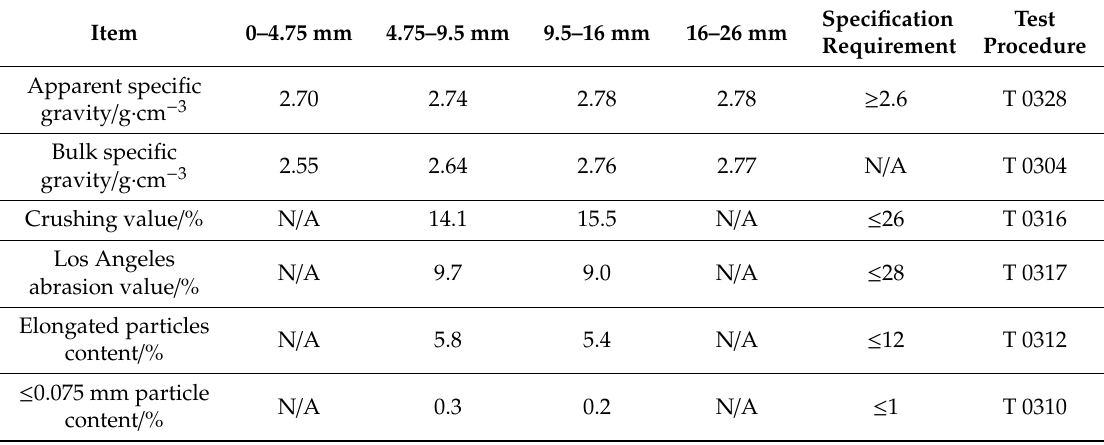
Table 4. Technical parameters of aggregate.